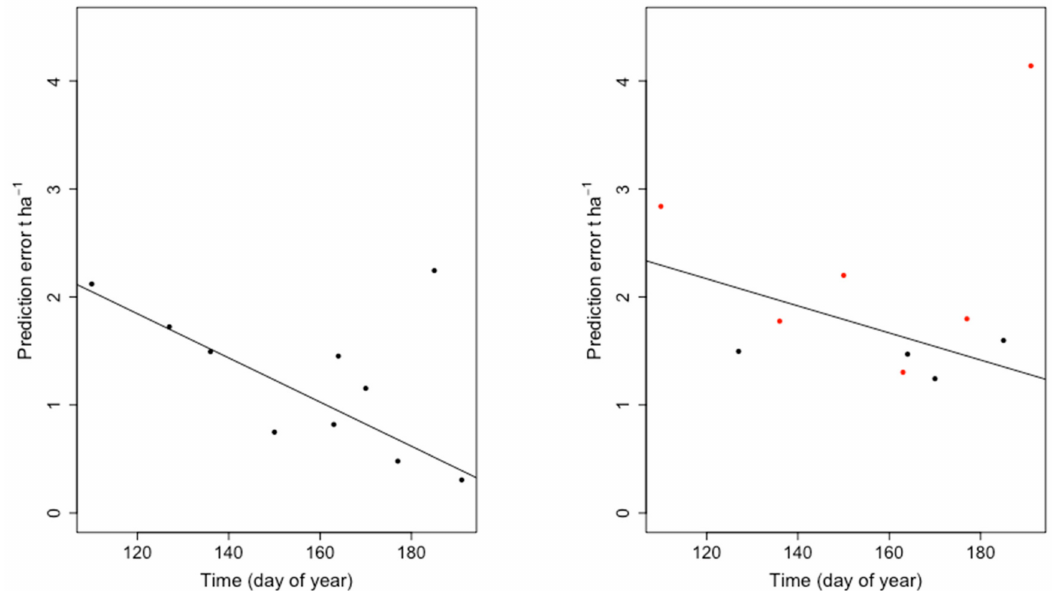
Figure 6. Yield prediction error (t ha − 1 ) from the 3-factor linear model (Yield~HEIGHT*LAI*DOY) and its variation with antecedence (time of canopy observation, day of year; 120 = 30 April, 180 = 29 June). Left panel : Predictions derived from 10-fold cross-validation using 90% of all available data for fitting in each fold. The regression line is fitted to all data except the outlier on day of year 185, 2018. The adjusted r 2 is 0.74. Right panel : Predictions are derived from a calibration on one year/site and a test on the other year/site. The red symbols are for the model fit on 2017 data and validated on 2018; the black symbols show the validation on 2017 data using a fit on 2018 data. The line shows a linear model fitted to all data except the outlier on day 191, 2017. The adjusted r 2 is